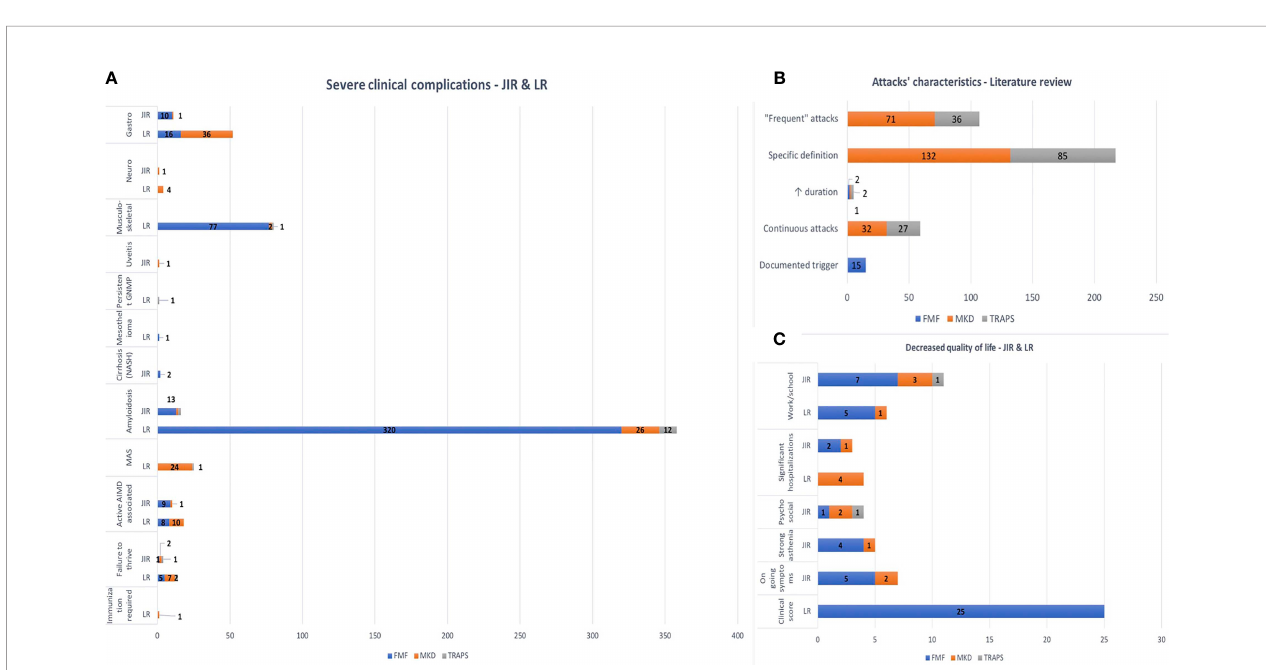
FIGURE 2 | (A) Severe clinical complications. (B) Attacks ’ characteristics – literature review. (C) Decreased quality of life. FMF, familial Mediterranean fever; MKD, mevalonate kinase de fi ciency; TRAPS, tumor necrosis factor receptor-associated periodic syndrome; LR, literature review; GNMP, membrano-proliferative glomerulonephritis; MAS, macrophage activation syndrome; AIMD, auto-immune disease.